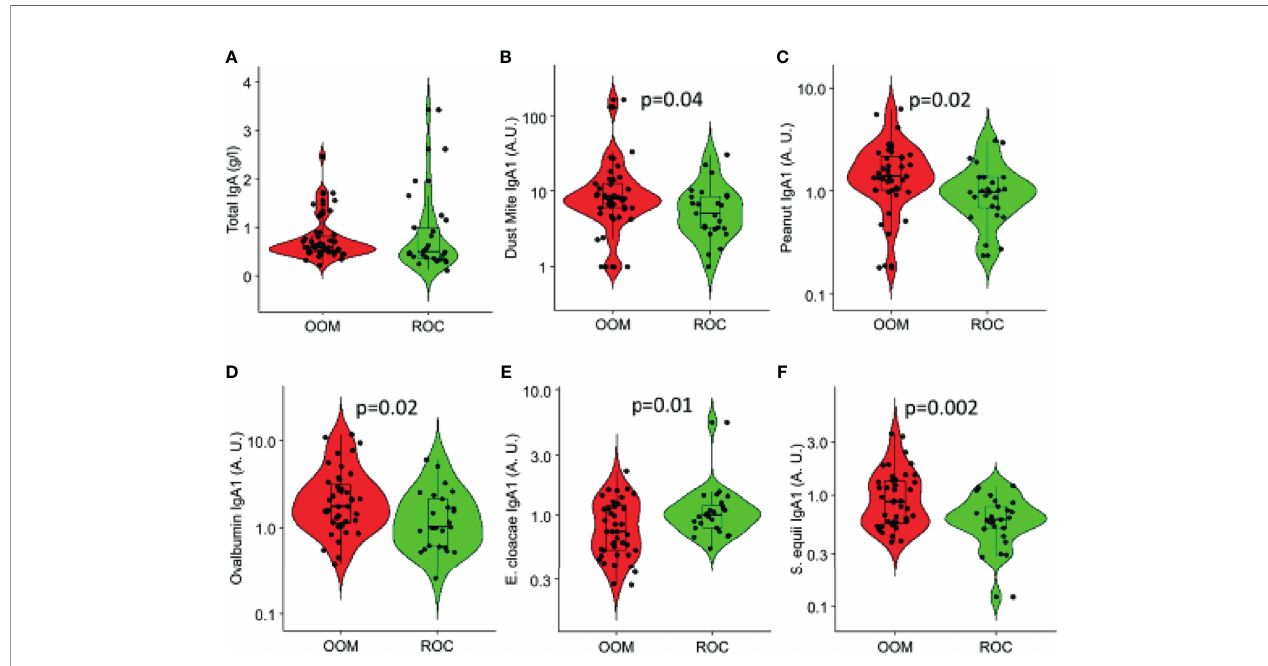
FIGURE 2 | Total and speci fi c IgA responses in human milk that are signi fi cantly different between the OOM (red) and Rochester (green) mothers. (A) Total IgA and IgA speci fi c to (B) dust mite (Der p1 and Der f1), (C) peanut, (D) ovalbumin, (E) E. cloacae , and (F) S. equii are shown. Antigen-speci fi c IgAs are normalized between 0 and